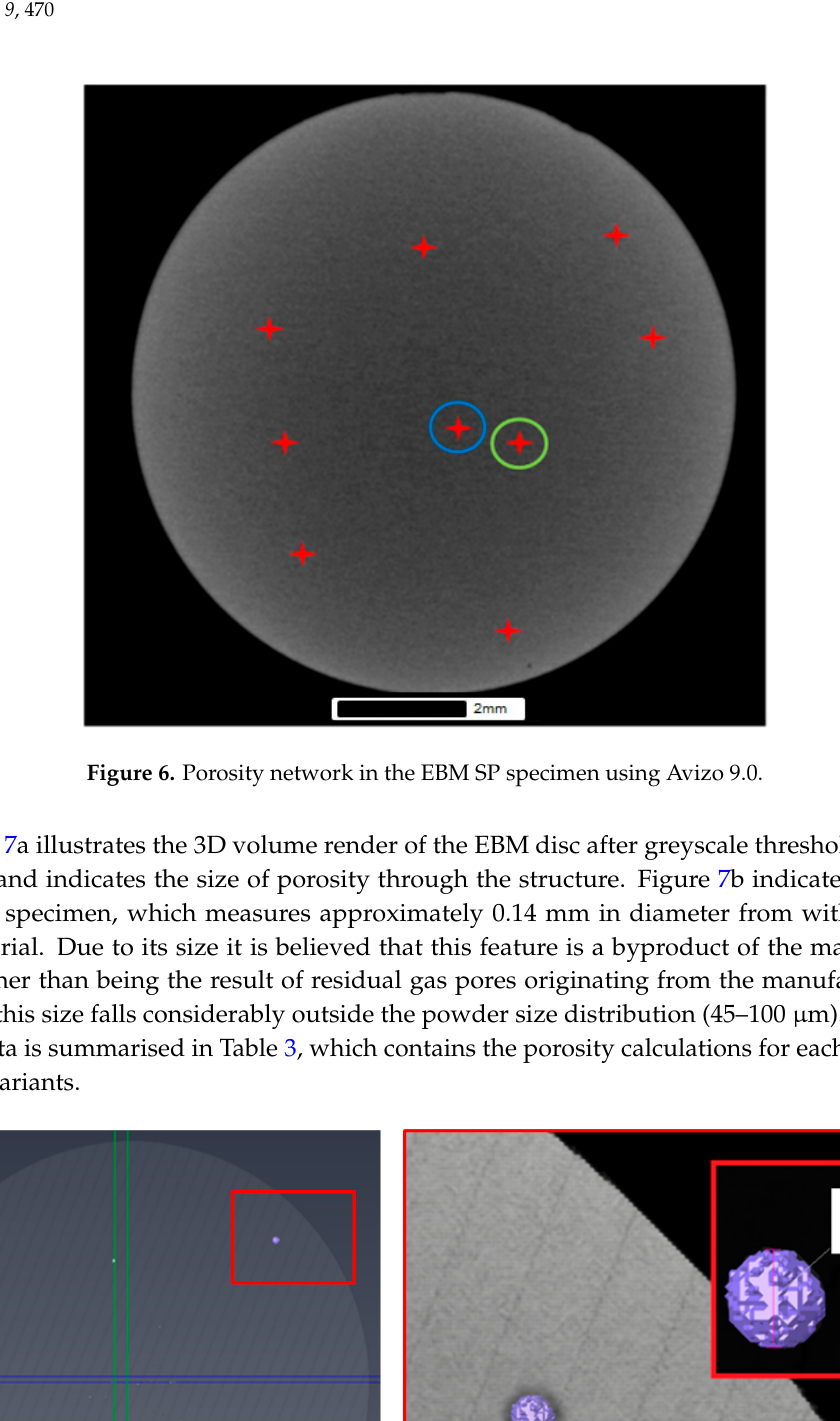
Figure 5. Image showing a volume render of the small punch specimen both ( a ) before and ( b ) after trimming in Avizo 9.0.